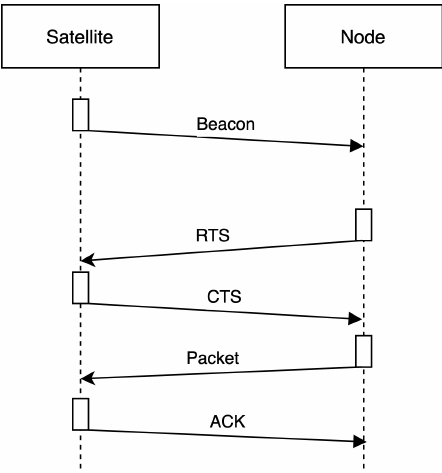
Figure 5. Sequence diagram for CSMA/CA with RTS/CTS medium sensing